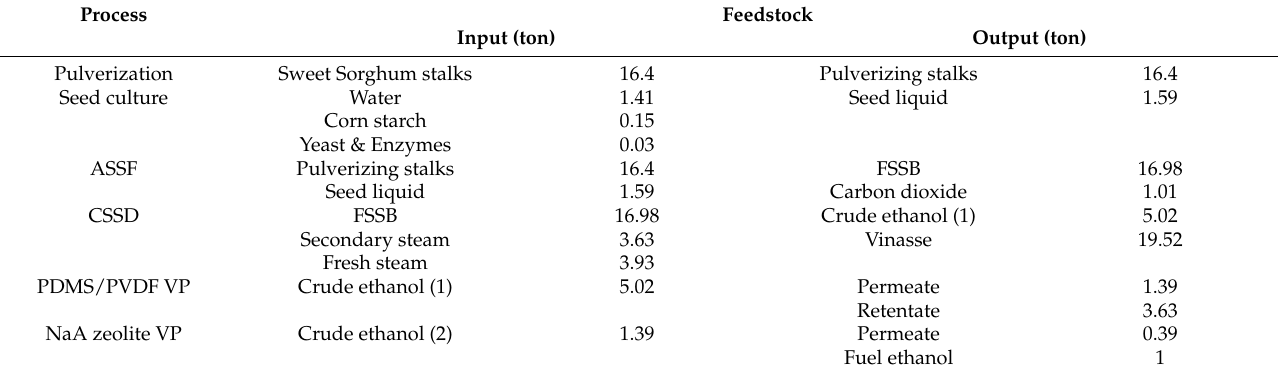
Figure 3. Flowsheets of one phase transition bioethanol separation process. Table 2. Mass balance of OPTS bioethanol process based on 1 ton